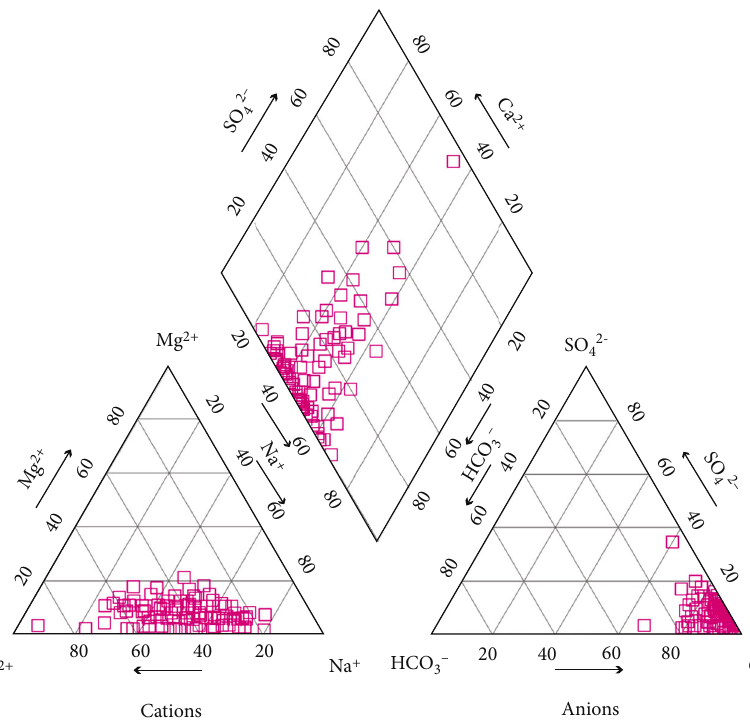
Figure 4: Piper diagram of formation water hydrochemical classi fi cation. This fi gure consists of a cation triangle (left), an anion triangle (right) and an anion-cation comprehensive map (middle).